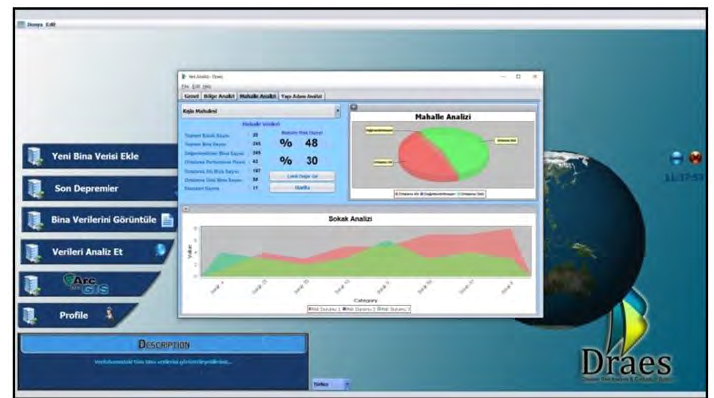
Figure 13. Analysis of Data - Neighborhood Analysis